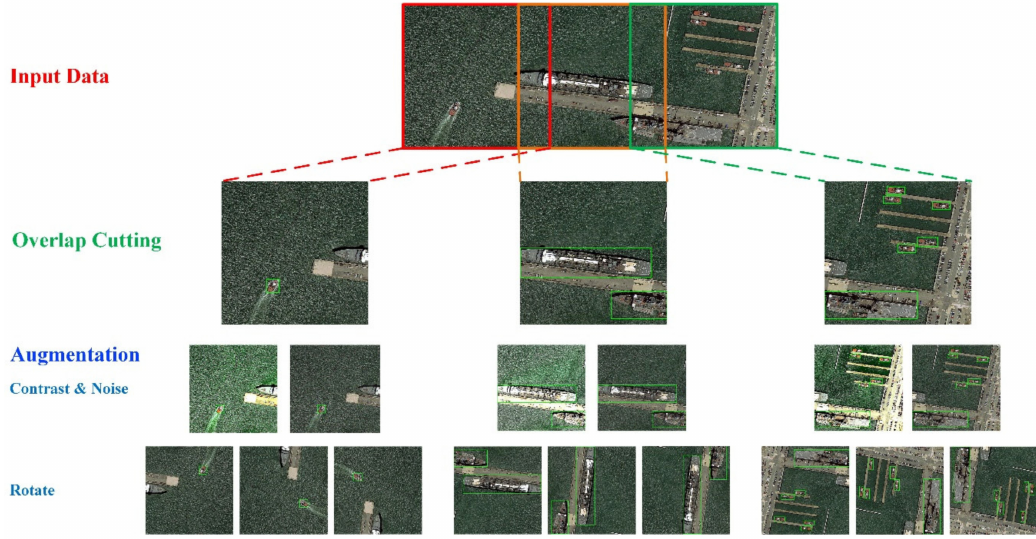
Figure 2. The results of the preprocessing of input